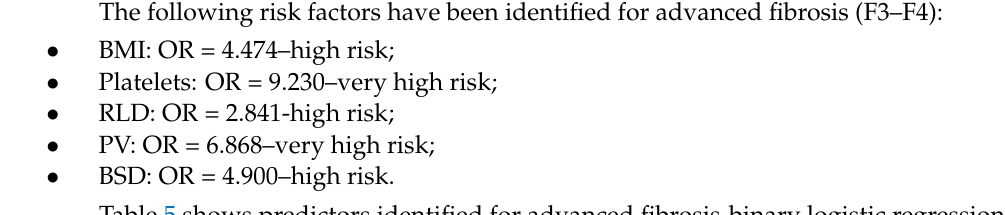
Table 5 shows predictors identified for advanced fibrosis-binary logistic regression. Table 5. Predictors identified for advanced fibrosis - binary logistic